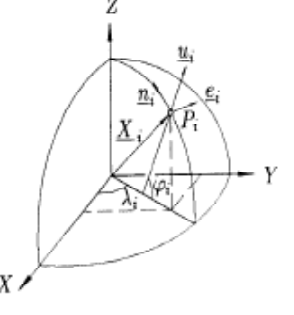
Fig. 1. Local topocentric coordinate system (Wellenhof et al.